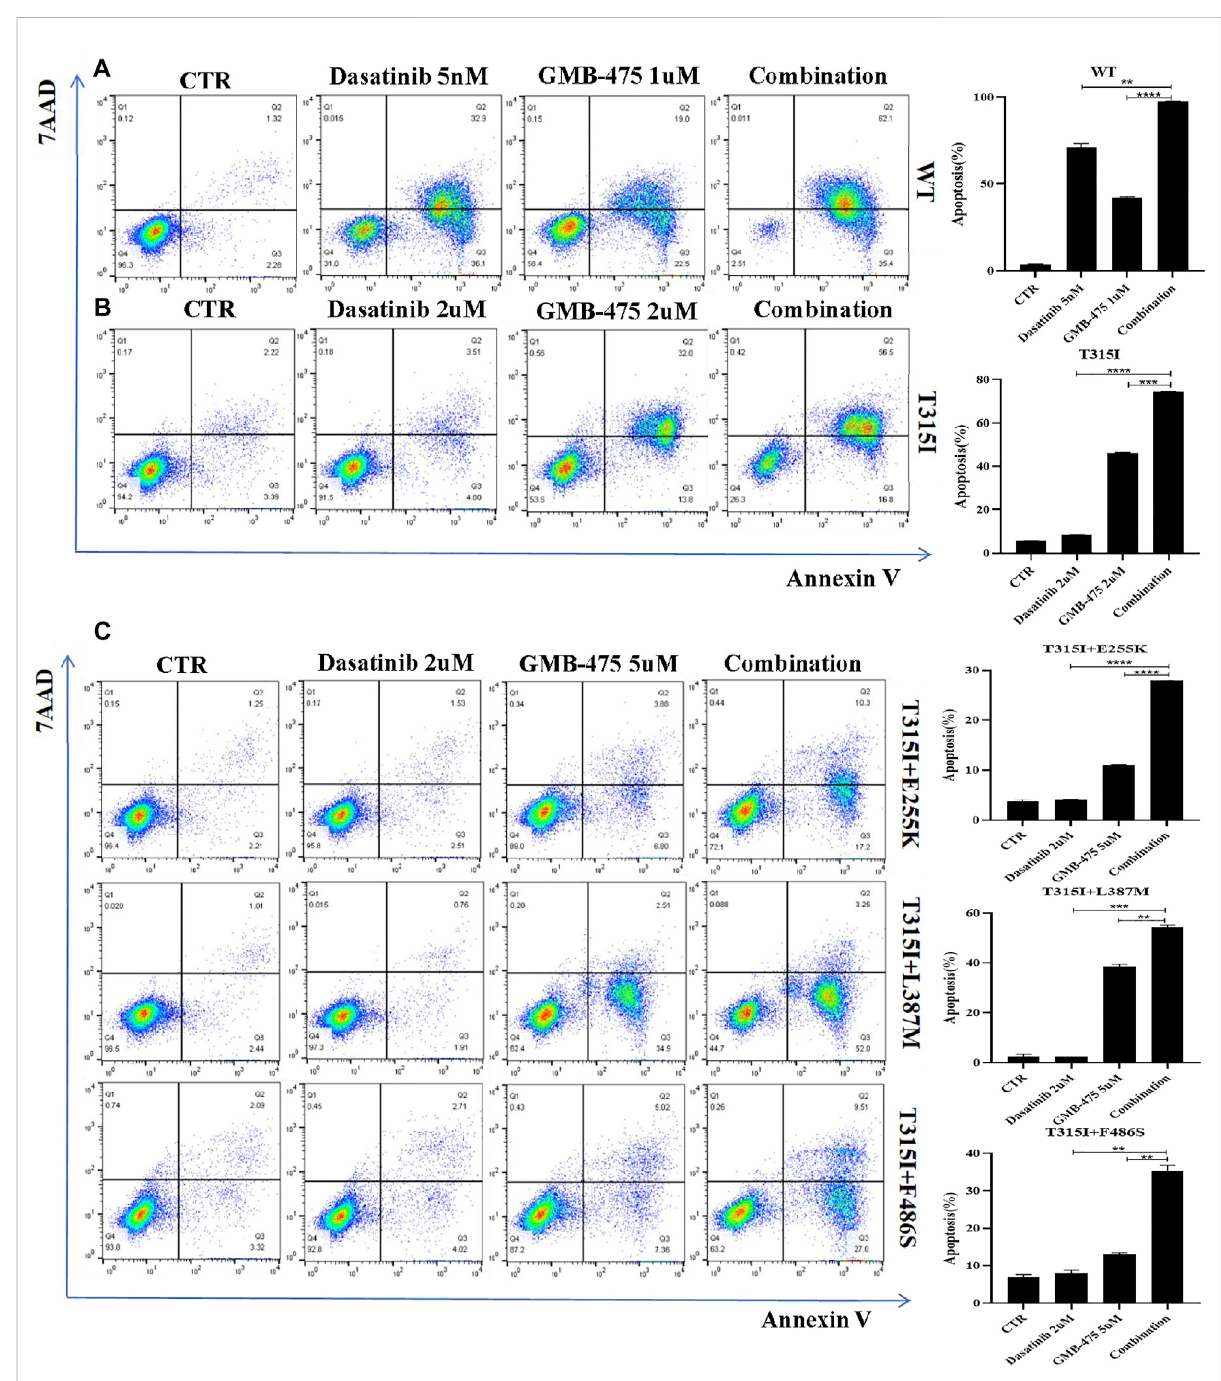
GMB-475 combined with dasatinib synergistically promoted the apoptosis of Ba/F3-MIG-p210 cells. The apoptosis of Ba/F3-MIG-p210 cells treated with control medium (CTR), GMB-475, dasatinib, or GMB-475 plus dasatinib for 48 h was detected via annexinV and 7-AAD double staining: (A) Ba/F3-MIG-p210 cells with BCR::ABL1 WT were treated with CTR, dasatinib 5nM, GMB-475 1 µM, and GMB-475 1 µM plus dasatinib 5 nM. (B) Ba/ F3-MIG-p210 cells carrying BCR::ABL1 T315I were treated with CTR, dasatinib 2 µM, GMB-475 2 µM, and GMB-475 2 µM plus dasatinib 2 µM.